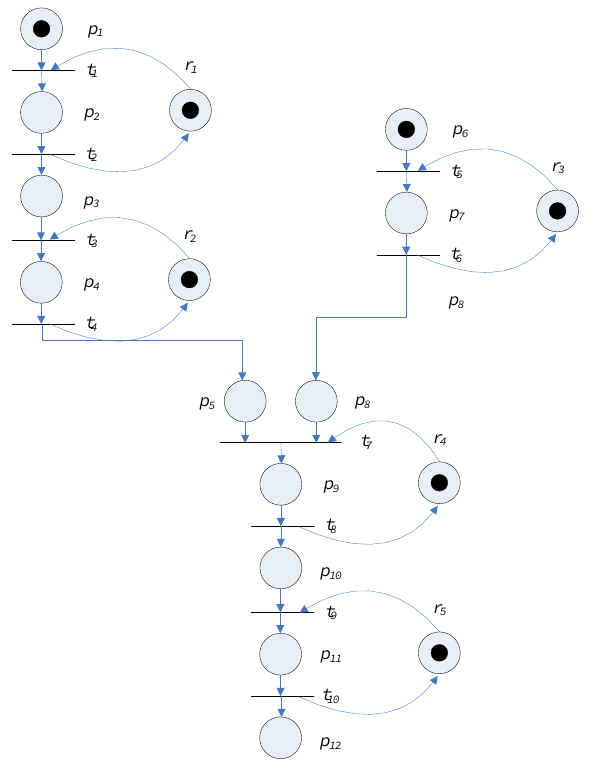
Figure 9. ( a ) A DTPN model represented by Ψ 1 (cid:107) Ψ 2 (cid:107) Ψ 3 as shown in Figure 10 (all resources are assumed to stay in the corresponding idle state places initially and all parts are in the corresponding input places of process agent W 1 and process agent W 2).